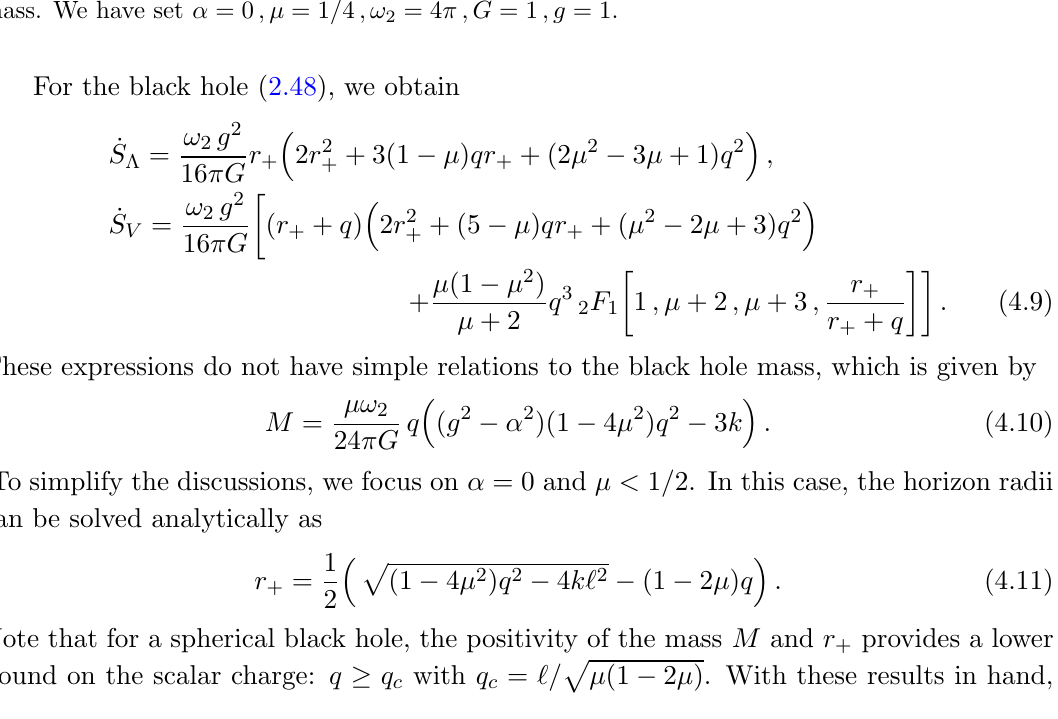
Figure 5 . The ratios _ S (cid:3) = 2 M (Blue) and _ S V = 2 M (Red) are plotted as functions of the black hole mass. We have set (cid:11) = 0 ; (cid:22) = 1 = 4 ; ! 2 = 4 (cid:25) ; G = 1 ; g =